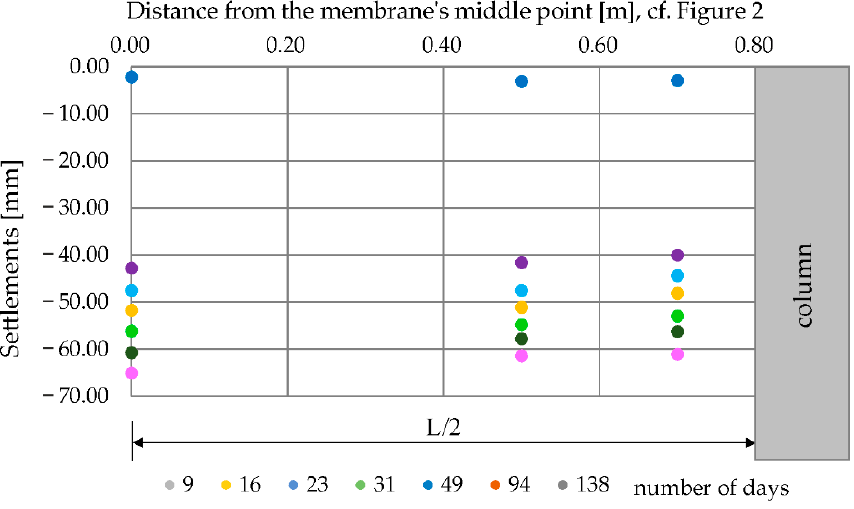
Figure 8. Results of measurements of the settlement of reinforcement between columns from the zero level of the column head—Section 4R (based on [13]).